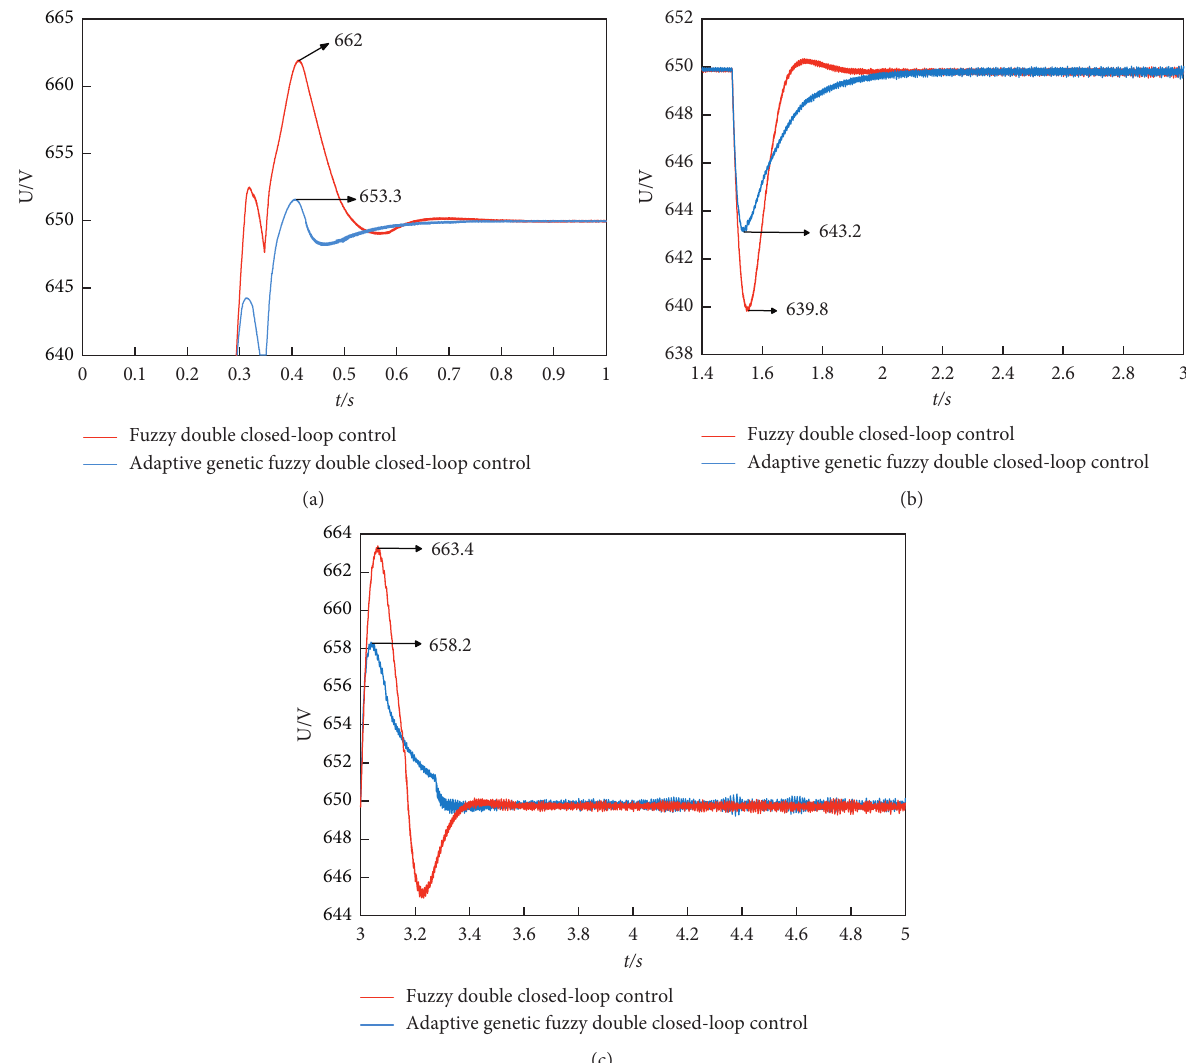
Figure 12: Voltage comparison of microgrid 2 bus. (a) Initial power-on. (b) Sudden increase of load. (c) A sudden drop in load.